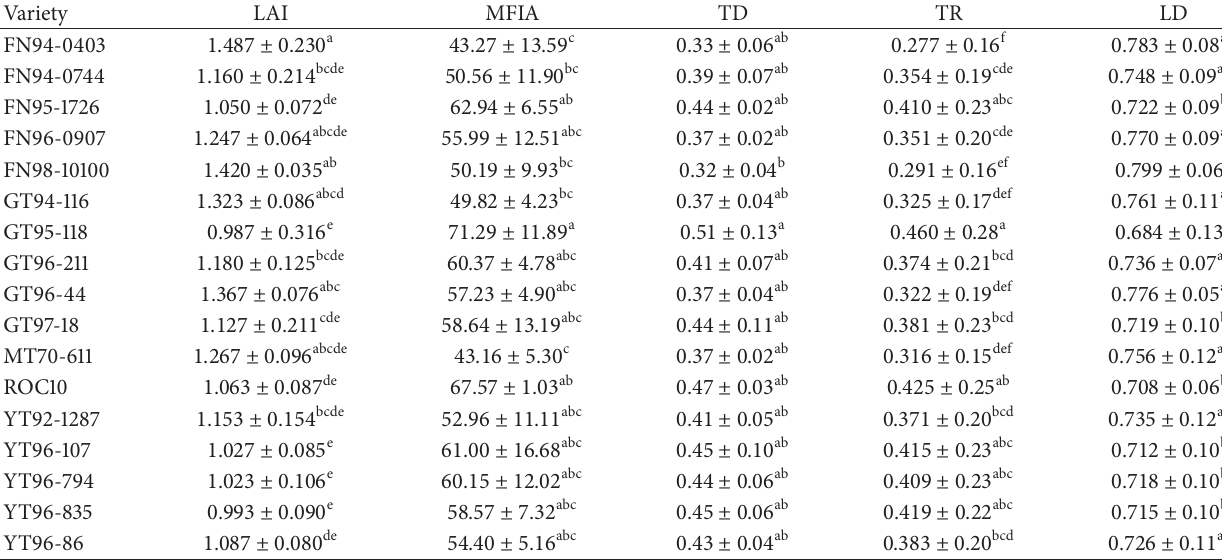
Table 4: Difference of canopy parameters among 17 sugarcane varieties.